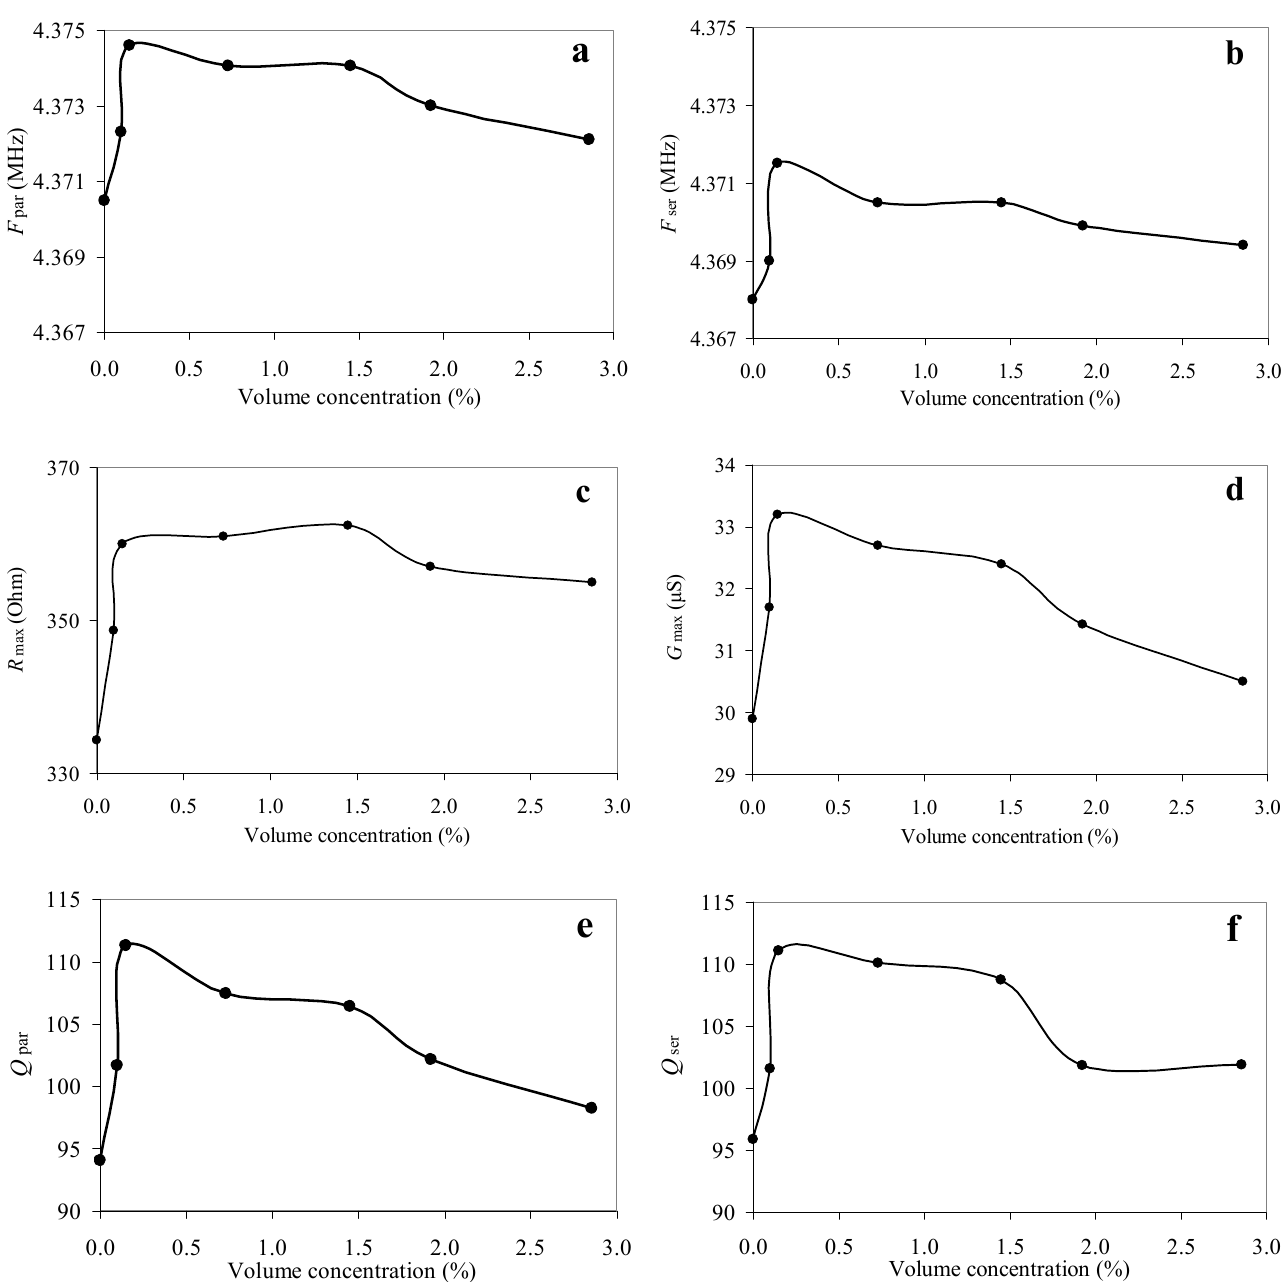
Figure 3. The dependences of the resonant frequency of the parallel ( a ) and series ( b ) resonances, the maximum values of the real parts of the electrical impedance ( c ) and admittance ( d ), as well as the quality factor of the parallel ( e ) and series ( f ) resonances of the quartz resonator on the volume concentration of the diamond particles in the